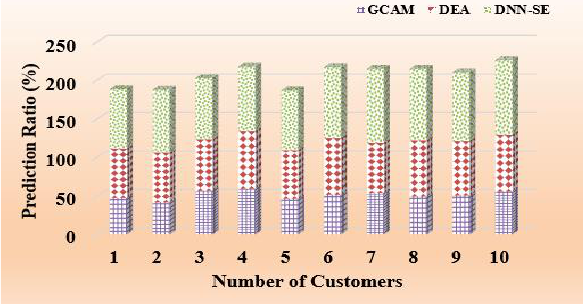
Figure 7. Prediction ratio.